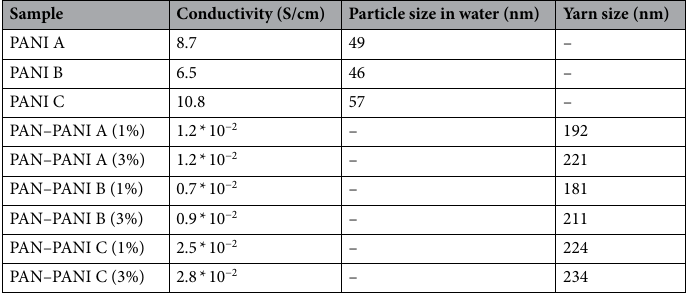
Table 4. Electric conductivity and fiber size of polymers and conductive